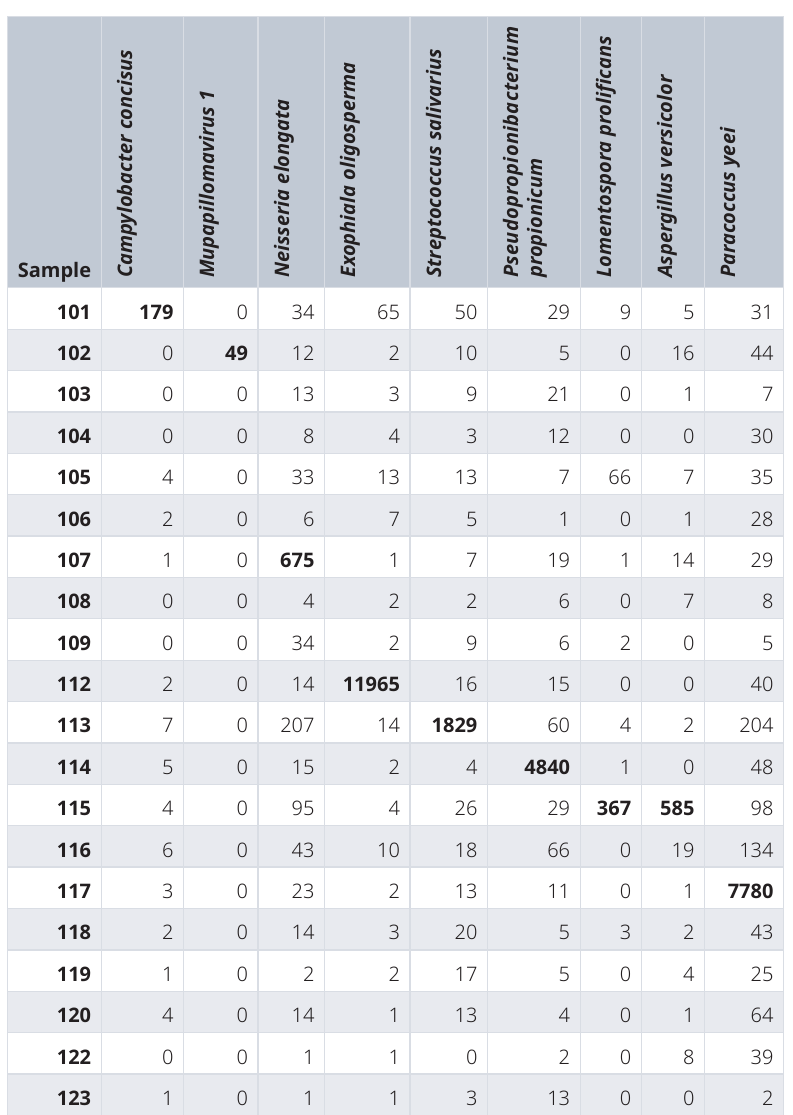
Table 3. Number of reads identified in each sample for species identified as possible pathogens. For each column, the value in bold text is significantly higher than any other value in that